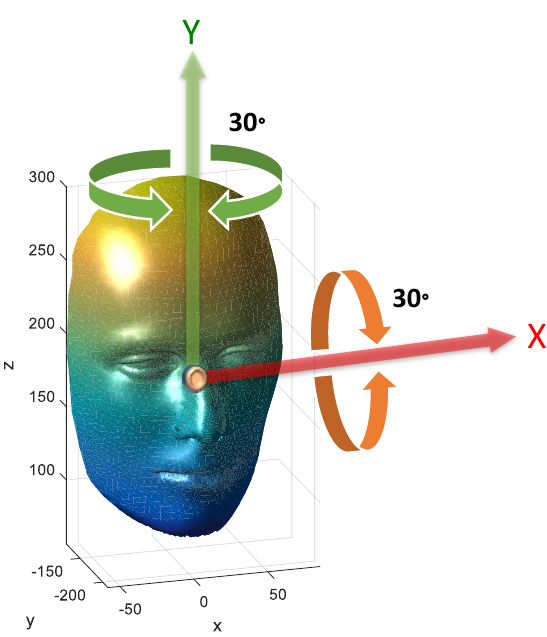
Figure 23. Illustration of 3D facial point cloud pose.